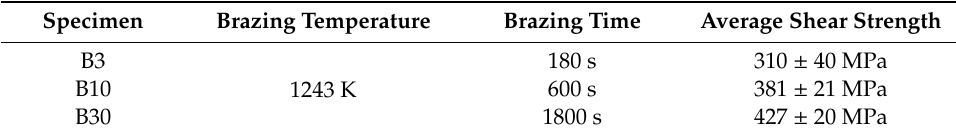
Table 3. Average shear strengths of distinct brazed samples.